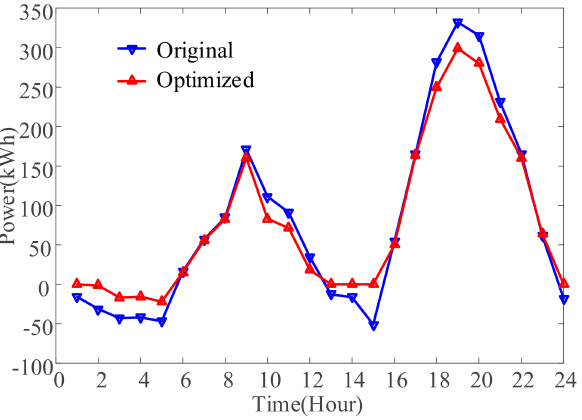
Figure 8. Electricity trading between MGO and